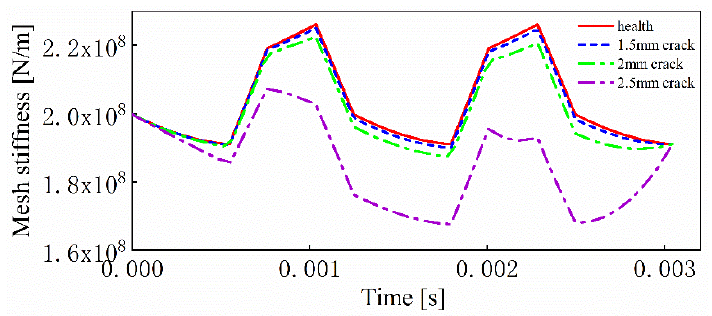
Figure 7. Stiffness values at different crack depths.